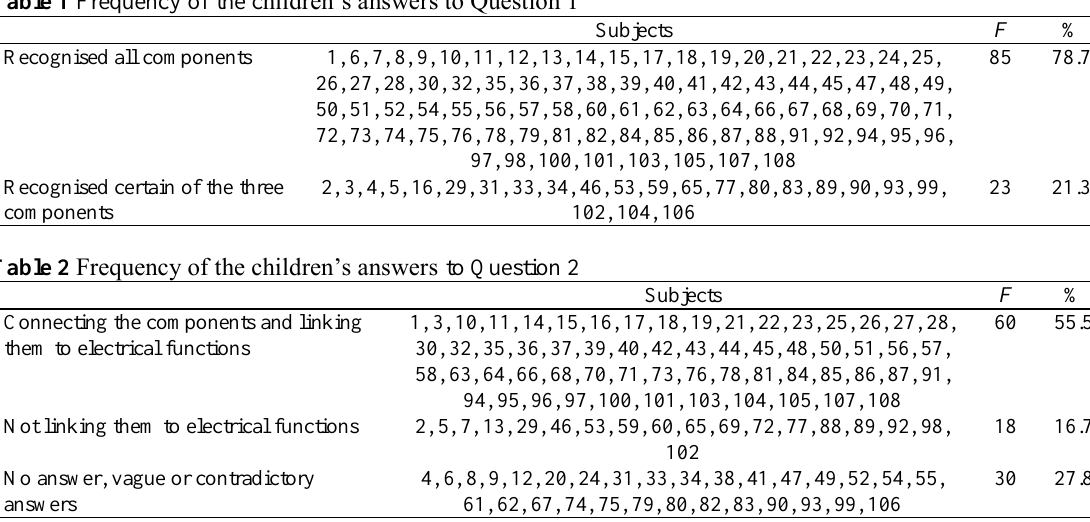
Table 1 Frequency of the children’s answers to Question 1 Recognised all components